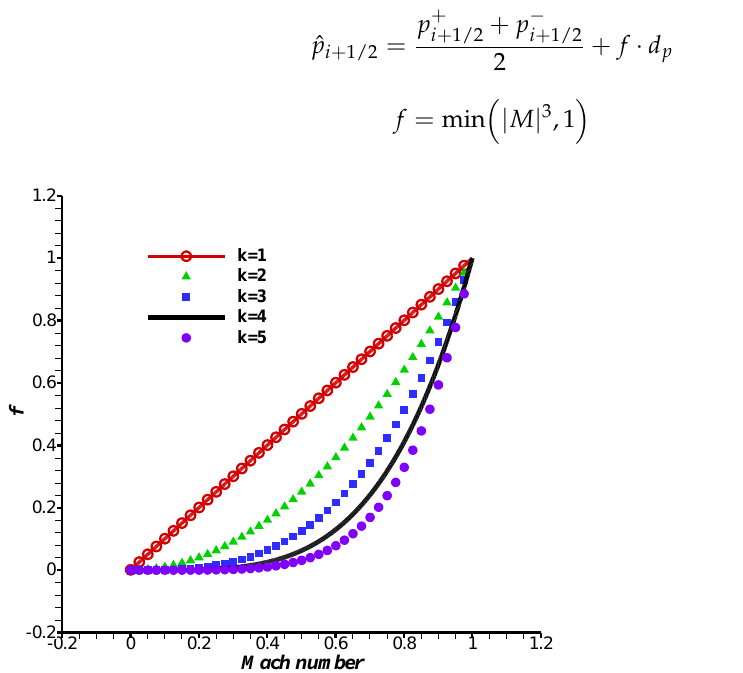
Figure 2. Distributions of the function f with different k ’s definitions when − 1 ≤ | M | ≤ 1 .